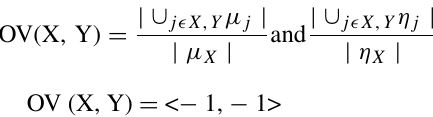
Overlapping ratio for N-cubic Pythagorean fuzzy